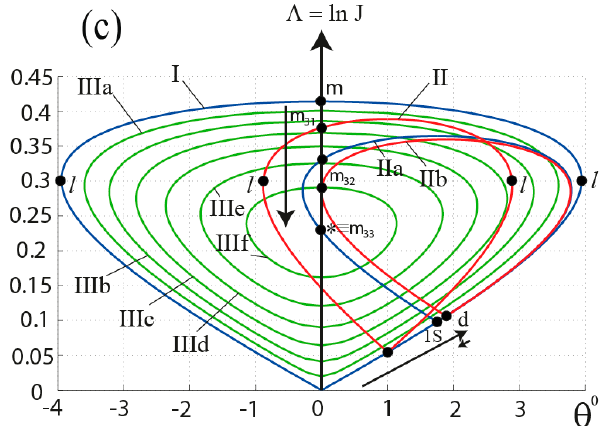
Figure 2. Graphic solution using shock polars: ( a ) at M > M b (here M = 5 ); ( b ) at M a < M < M b (here M = 1.8 ); ( c ) at M < M a (here M = 1.2 ). Polars IIIa–IIIf correspond to pulsed energy release at the main shock equal to 15, 30, 45, 60, 75 and 90% of the maximum value φ ∗ ; point “ ∗ ” corresponds to this maximum value. Vertical arrows point to variation of Mach shock strength (it diminishes as pulsed energy release increases). Inclined arrows correspond to variation of strength of the incident shock forming the SMC (it decreases at M > M b , but at M < M b it initially increases and decreases only afterwards, at larger pulsed energy releases). Point l corresponds to shocks with maximum flow deflection angles, point N to von Neumann criterion, point d to the detachment criterion, and point 1 s to the incident shock that forms the SMC at maximum impulse energy release.